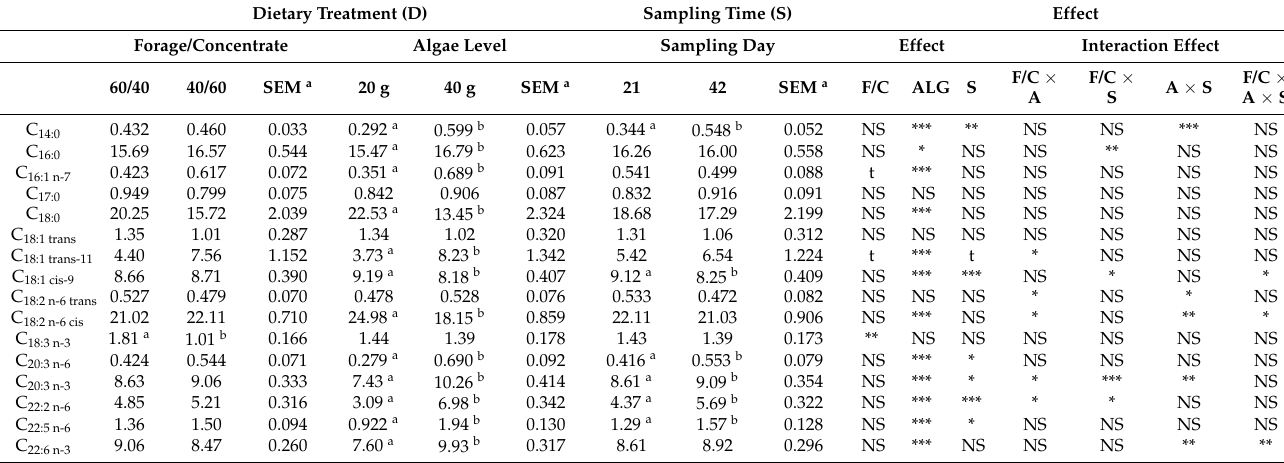
Figure 4. Pearson correlation of milk fatty acids of goats in four dietary treatments. Table 4. The mean individual fatty acids (FA) (% of total FA) in the blood plasma of goats fed diets (20 HF, 20 HG, 40 HF, and 40 HG) with different levels of Schizochytrium spp. (20 g and 40 g/goat/day) and two different forage to concentrate ratios (60:40 and 40:60) throughout the experimental period (21st and 42nd experimental days).